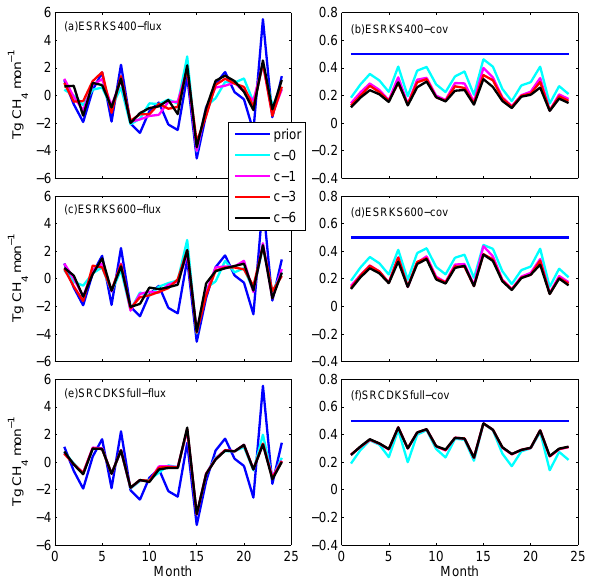
Fig. 6. Two-year comparison of the posterior fluxes and poste- rior uncertainties between inversions using the different ensemble Kalman update smoothers. The true fluxes have been subtracted from the time series for a better illustration. The ESRKS in panels (a) and (b) uses an ensemble size 400, and uses an ensemble size 600 in (c) and (d) . The SRCDKS in panels (e) and (f) uses a ensem- ble size 305. Interval constraints are applied for all inversions using the variable transform algorithm described in the